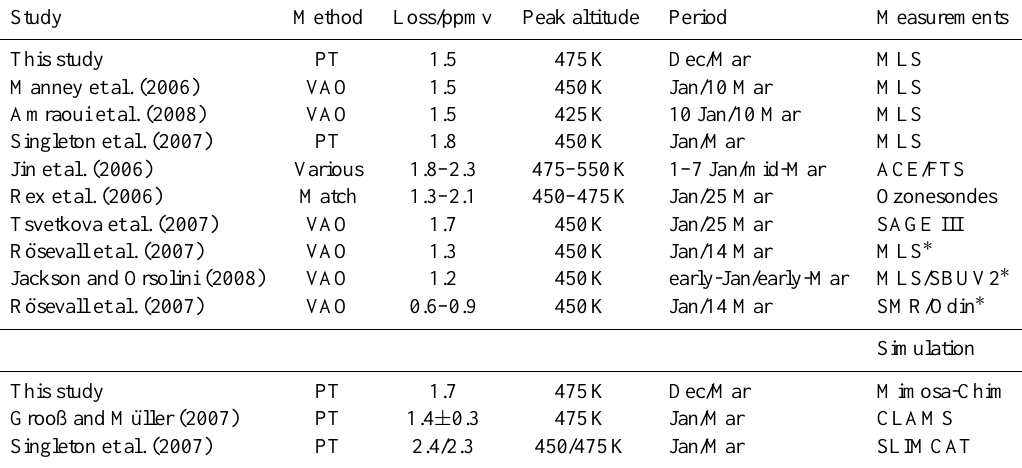
Table 1. The vortex averaged ( ≥ 65 ◦ EqL) ozone loss estimated in volume mixing ratio (ppmv) from Mimosa-Chim and MLS data, compared to different studies for the Arctic winter 2005. The initial offset in tracer and Mimosa-Chim ozone is corrected with respect to MLS ozone to avoid any bias in ozone loss computations. The passive tracer method is denoted by PT and the vortex averaged/profile descent method is denoted by VAO. The ozone loss analyses based on assimilated data are indicated by ∗